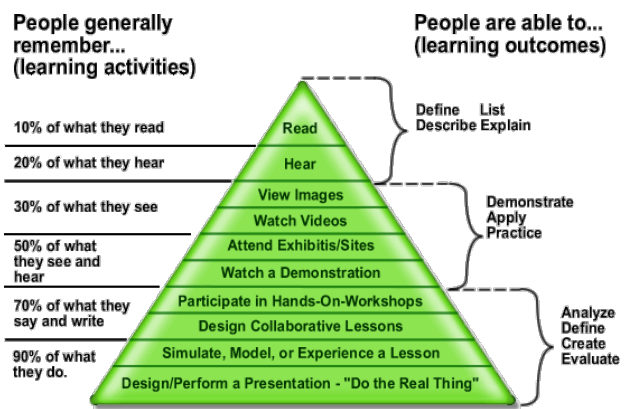
Figure 1. cone of experience (Source: This file is licensed under the Creative Commons Attribution- Figure1. cone ofexperience(Source: ThisfileislicensedundertheCreativeCommonsAttribution-Share Share Alike 3.0.) deducted by E. Dale. Alike 3.0.) deducted by E.